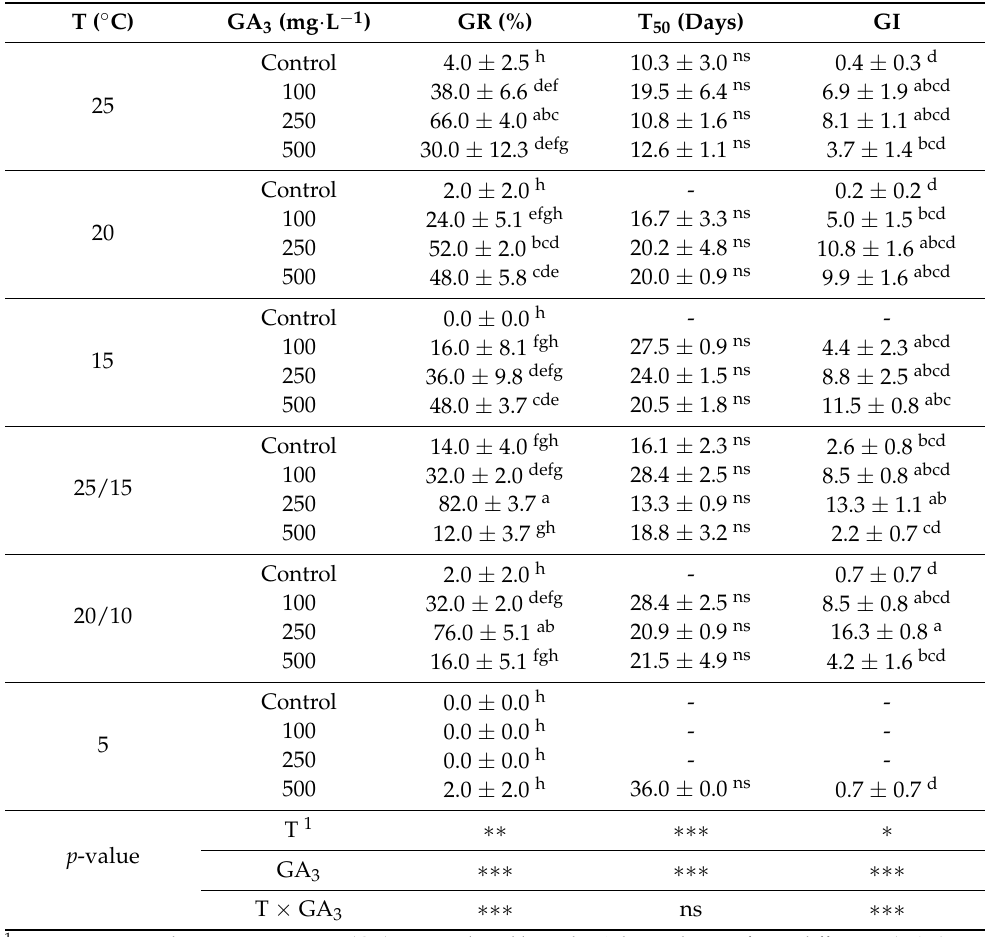
Table 1. The effect of gibberellic acid treatments (100, 250, and 500 mg · L − 1 ) and temperature treatments on the germination vigor of L. coreana